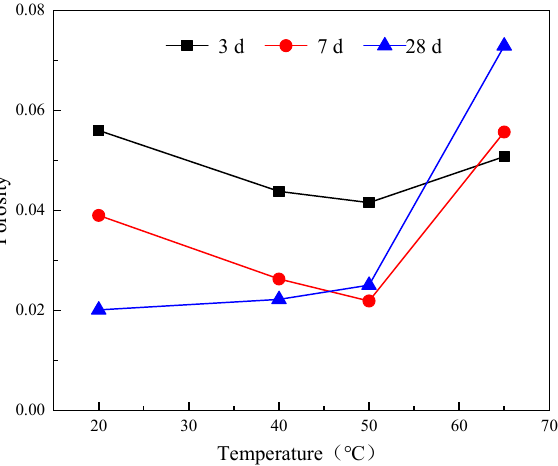
( b ) 50 °C Figure 13. SEM images of samples at 28d under different temperature conditions. It can be seen from Figures 14 and 15 that the curing temperature increase to a certain extent (up to 50 °C ) leads to the reduction of porosity and the refinement of pore structure at 3d and 7d. For the samples with a curing time of 3d, the porosity at 50 °C was 14.77% lower than that at 20 °C , and the average pore diameter was 7.8% lower than that at 20 °C . The porosity at 50 °C for 7d was 14.29% lower than that at 20 °C , and the average pore diameter was 13.4% lower. This is because within a range ( ≤ 50 °C ), high curing tempera- ture promotes the hydration of cement which leads to more cement hydration products and a finer cement matrix porosity. This was also confirmed by previous thermal analysis and XRD analysis. However, when the temperature reached 65 °C , the porosity and aver- age pore diameter in 3d and 7d were higher than those at curing temperatures less than 65 °C , the porosity was 8.3% and 26.67% higher than that at 50 °C , and the average diam- eter of pores was 10.6% and 15.3% higher, respectively. In addition, it is particularly noted